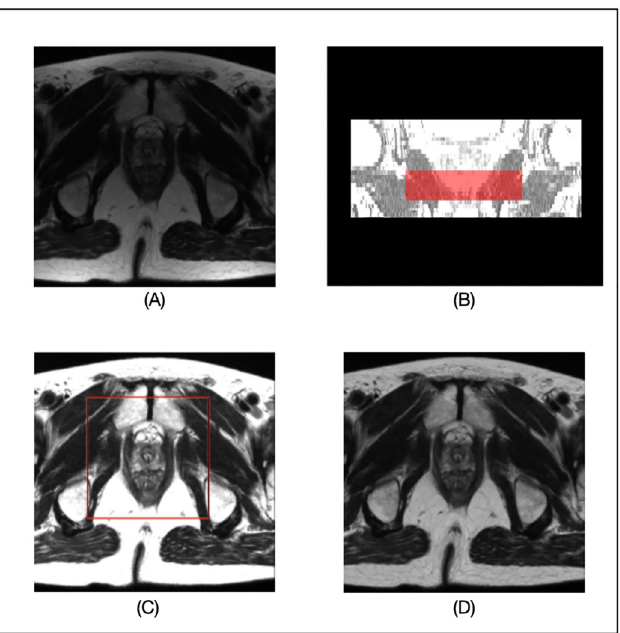
Fig 5. Preprocessing of DNN inputs for the prostate segmentation. (A) original image; (B) The segmented prostate_apex_box node ; (C) preprocessed image for input to the DNN in the prostate_apex_focused_cnn node (red box indicates the guided area for the local histogram generated from the prostate_apex_box node ); (D) preprocessed image used for the DNN in the prostate_whole_cnn node.